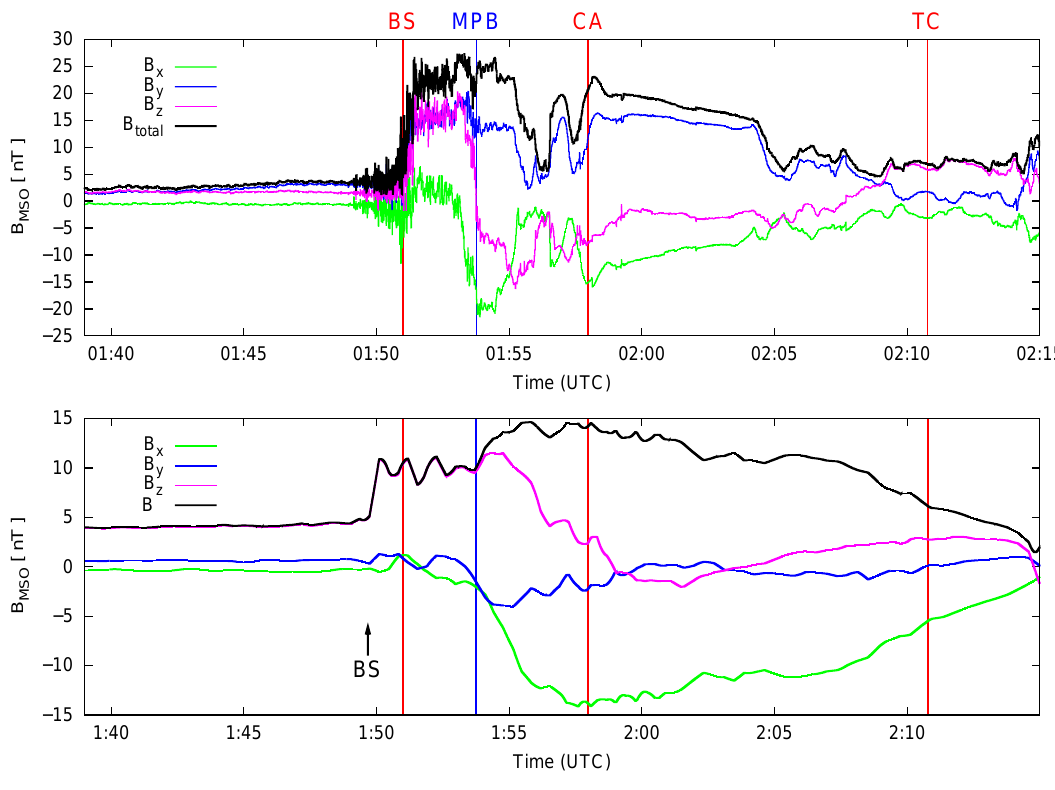
Fig. 9. ROMAP magnetic field data (top) in comparisons with results of the hybrid simulation (bottom). The hybrid model does not include effects of the crustal magnetic field which appear in the data between 01:56UT and 01:58UT. While Rosetta crosses the bow shock at 01:51UT the hybrid simulation gives a bow shock position around one minute earlier. These simulation results can explain the ROMAP measurements qualitatively very well, especially the decreasing field strength in all three components at the MPB position. The simulation results produce a total magnetic field which is about 10nT weaker than observed values. This can be explained by numerical smoothing during the simulations and unkown magnetic field offsets for the ROMAP measurements. Furthermore on-average conditions in the solar wind do not lead to a stationar picture of Mars-solar wind interaction which is given by the simulation. Only a IMF vector with a strong positive B z component is able to explain the negative B x component during measurements behind the bow shock. For an explanation see also Fig.